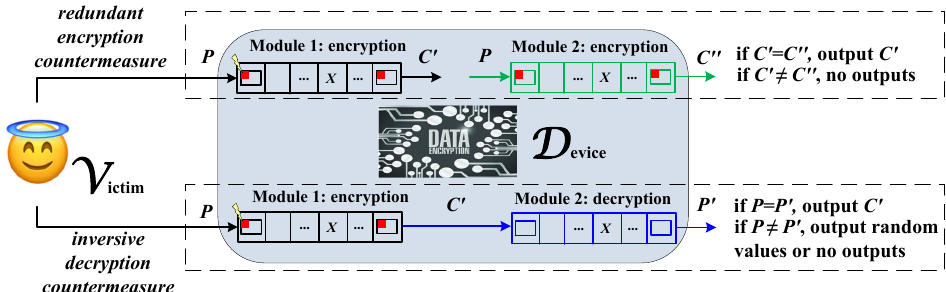
Figure 6: Countermeasures against fault attacks: REDMR and